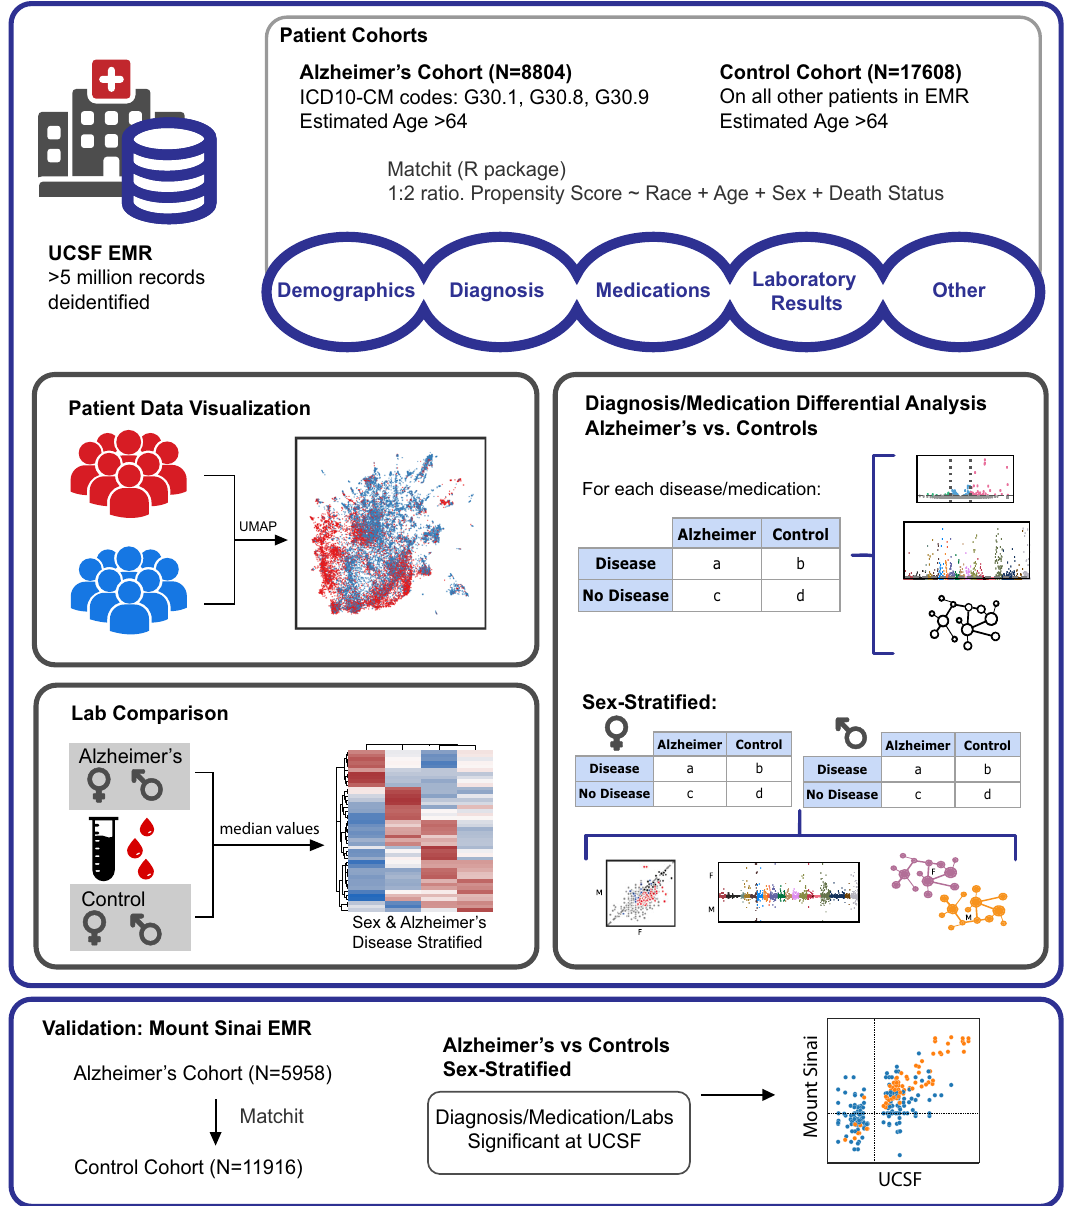
Fig. 1 Work fl ow visualization. Visualization of patient cohort identi fi cation from the UCSF EMR and methods for deep phenotyping and enrichment analysis. Validation analysis is done with Mount Sinai EMR to assess